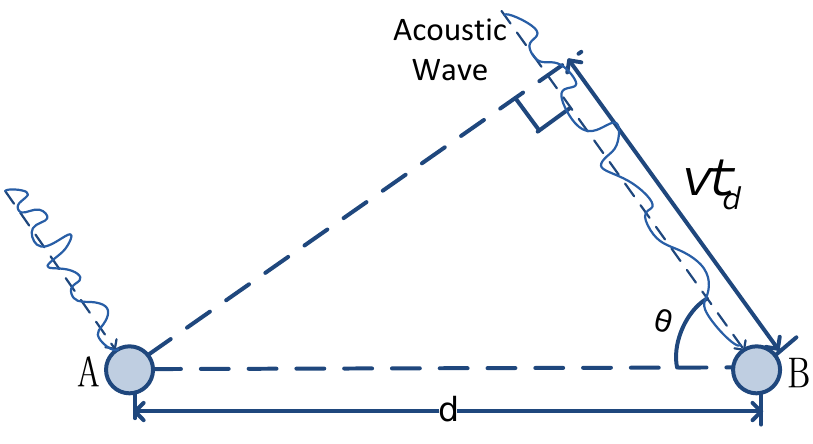
Figure 4. Acoustic wave arrives at two different